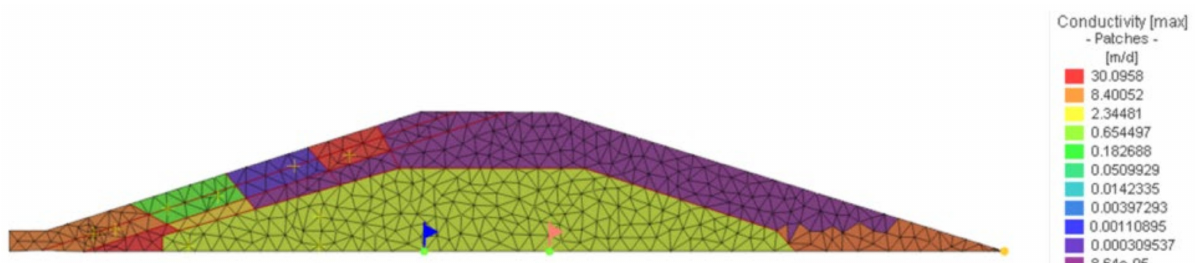
Figure 14. Saturated hydraulic conductivity in Var. 3 estimated with